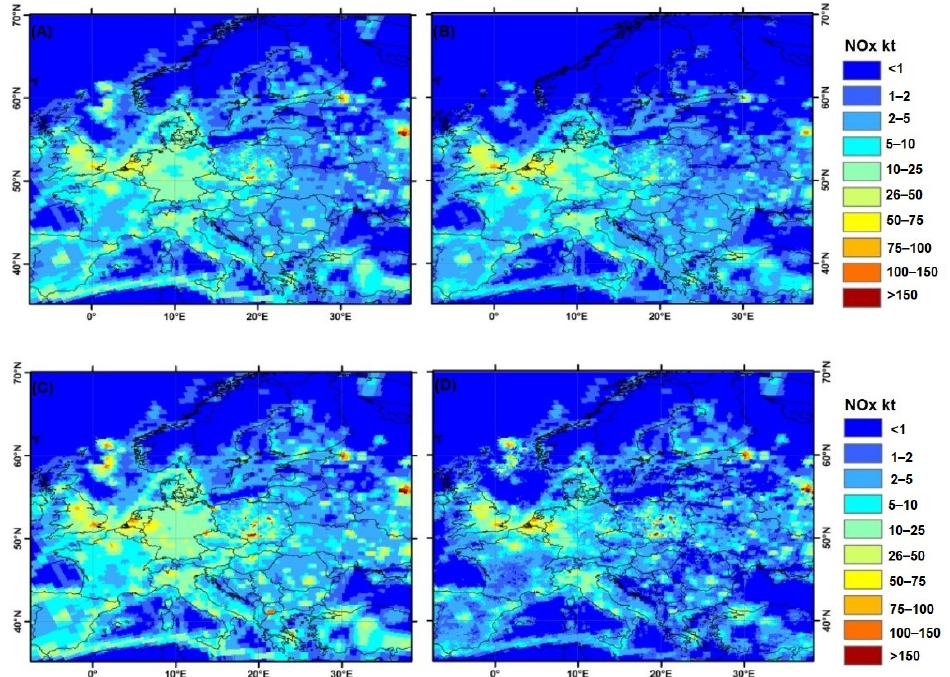
Figure 5. Comparison of NOx emission fluxes in 2010 for July (upper panels) and December (lower panels) before (left panels) and after (right panels) modifications.